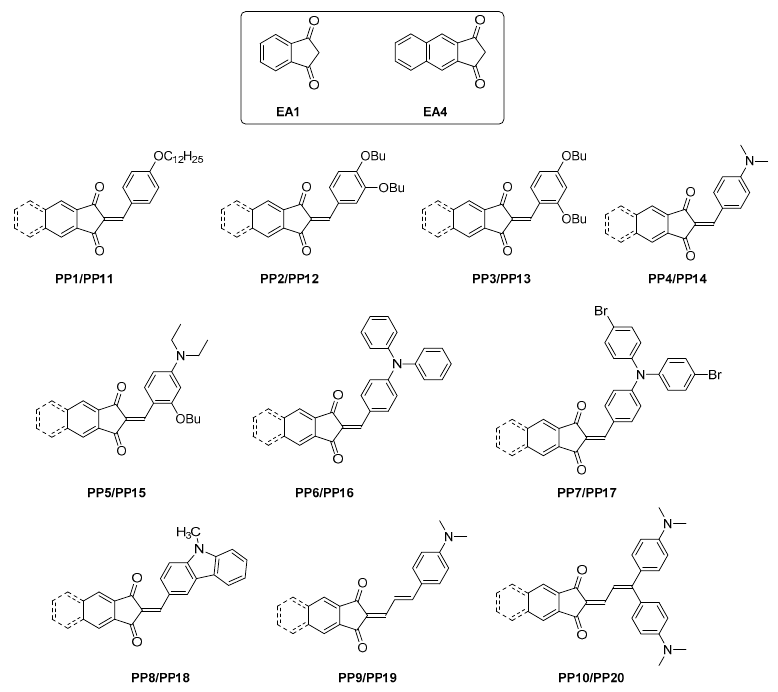
Figure 2. Chemical structures of the 20 dyes PP1–PP20 examined in this study. PP1–PP10 were made from EA4 , while PP11–PP20 were made from EA1